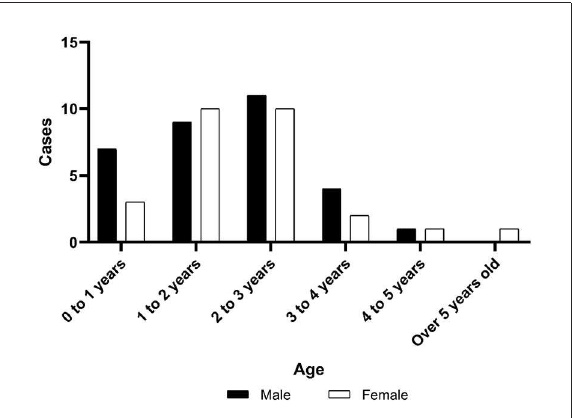
FIGURE1 Gender distribution of children in different age groups.